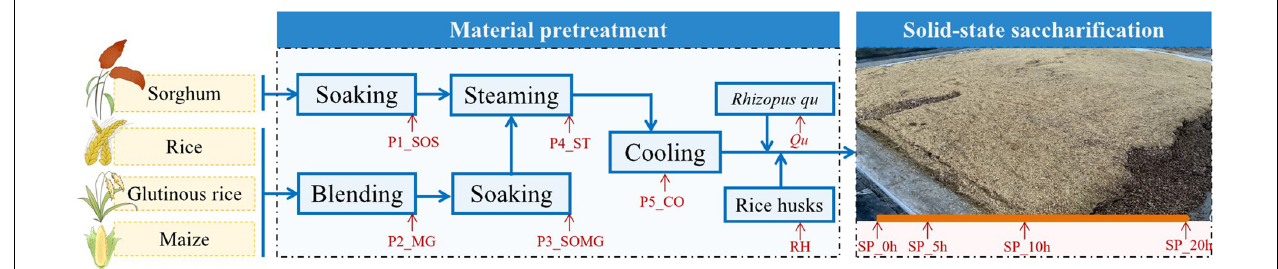
FIGURE 1 | Diagram of the raw material pretreatment and solid-state saccharification processes of fuyu -flavor baijiu